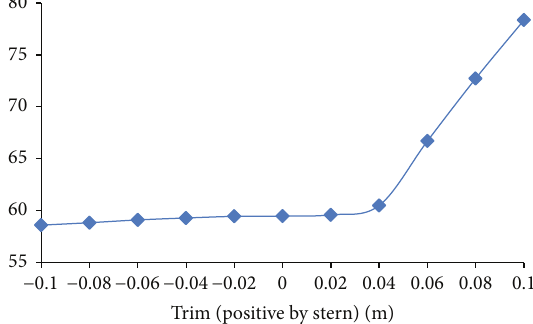
Figure 10: Viscous resistance as a function of trim.